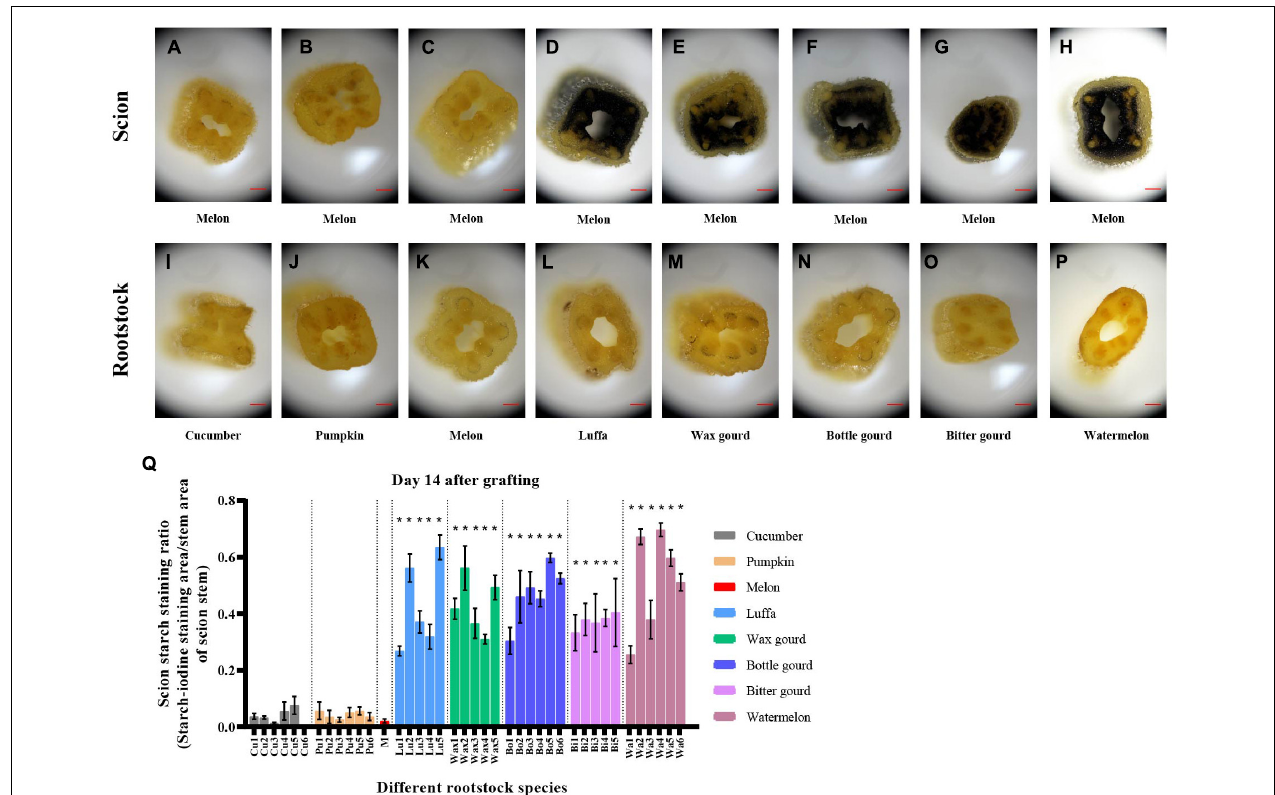
FIGURE 5 | Starch accumulations above and below the graft junction of melon grafted onto eight Cucurbitaceae rootstocks on day 14 after grafting. (A–H) Starch–iodine staining of scion stem above 2 mm of the graft junction of melon cv. ‘Akekekouqi’ grafted onto cucumber cv. ‘Jinyou No.35,’ pumpkin cv. ‘Qingyouzhen No.1,’ melon cv. ‘Akekekouqi,’ luffa cv. ‘Sanbi No.6,’ wax gourd cv. ‘Aonong,’ bottle gourd cv. ‘H19,’ bitter gourd cv. ‘Liangku No.1,’ and watermelon cv. ‘Zaojia 8424.’ Scale bar represents 500 µ m. (I–P) Starch–iodine staining of rootstock stem below 2 mm of the graft junction of melon cv. ‘Akekekouqi’ grafted onto cucumber cv. ‘Jinyou No.35,’ pumpkin cv. ‘Qingyouzhen No.1,’ melon cv. ‘Akekekouqi,’ luffa cv. ‘Sanbi No.6,’ wax gourd cv. ‘Aonong,’ bottle gourd cv. ‘H19,’ bitter gourd cv. ‘Liangku No.1,’ and watermelon cv. ‘Zaojia 8424.’ Scale bar represents 500 µ m. (Q) Scion starch staining ratio (starch–iodine staining area/transected area of scion stem) of melon cv. ‘Akekekouqi’ grafted onto cucumber (Cu1–Cu6), pumpkin (Pu1–Pu6), melon (M), luffa (Lu1–Lu5), wax gourd (Wax1–Wax5), bottle gourd (Bo1–Bo6), bitter gourd (Bi1–Bi5), and watermelon (Wa1–Wa6) on day 14 after grafting. Asterisks indicate a significant